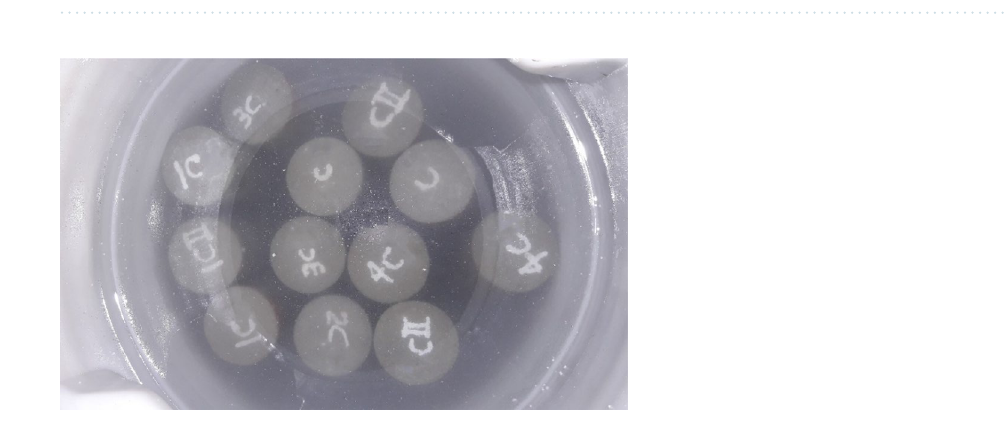
Figure 1. UPVC cylindrical molds and uncured samples.